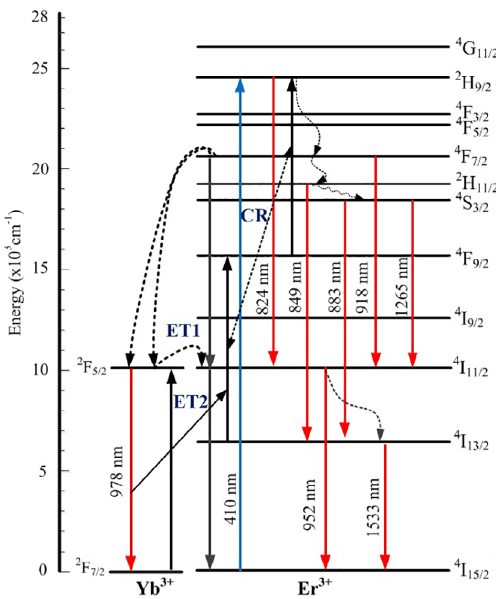
Figure 9. Mechanism for DC processes of the Er 3+ /Yb 3+ co- doped in SEY-1 glass-ceramics, under excitation 410